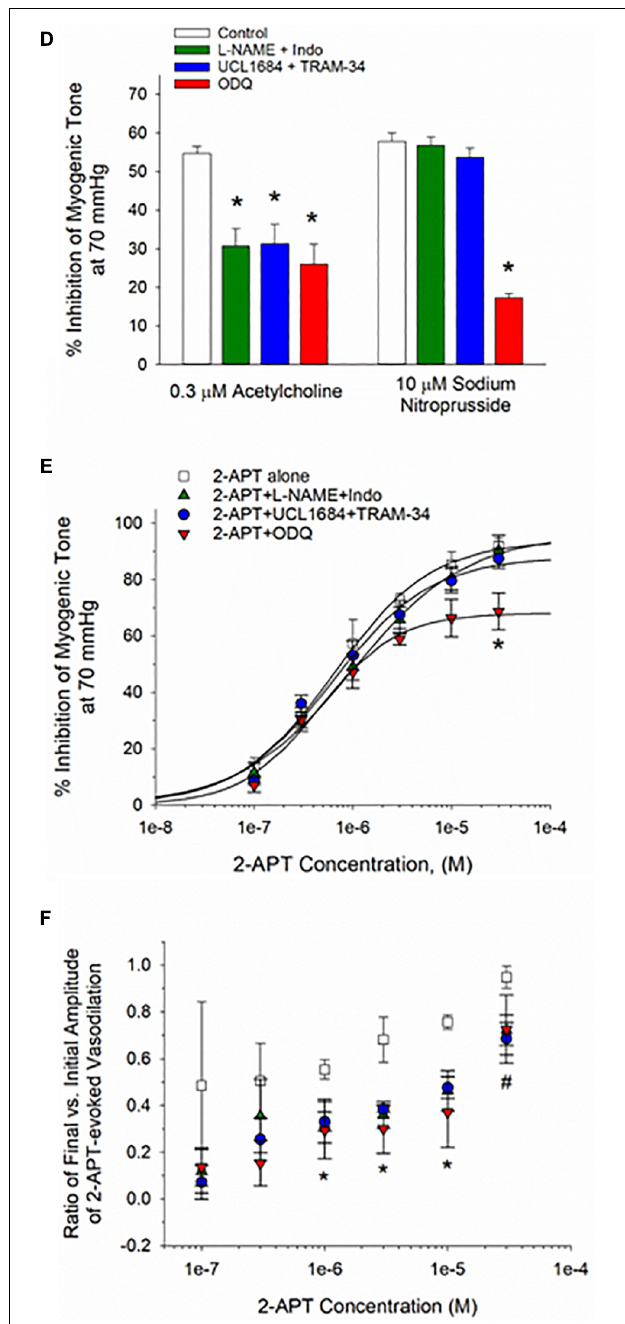
FIGURE 7 | Acute inhibition of established vasodilatory signaling pathways does not impair the 2-APT-evoked vasodilation of Sprague–Dawley rat cremaster arteries. The representative tracings in panels (A–C) depict the concentration-dependent vasodilation of myogenically constricted cremaster arteries by increasing concentrations of 2-APT in the presence of (A) L-NAME (100 µ M) + Indomethacin (10 µ M), (B) UCL 1684 (0.5 µ M) + TRAM-34 (1 µ M), inhibitors of endothelial KCa2.3 and KCa3.1 channels, respectively, or (C) the soluble guanylyl cyclase inhibitor ODQ (10 µ M). Under each treatment condition, arteries were also stimulated with the endothelium-dependent vasodilator acetylcholine (ACh, 0.3 µ M) and the smooth muscle relaxant (Continued)